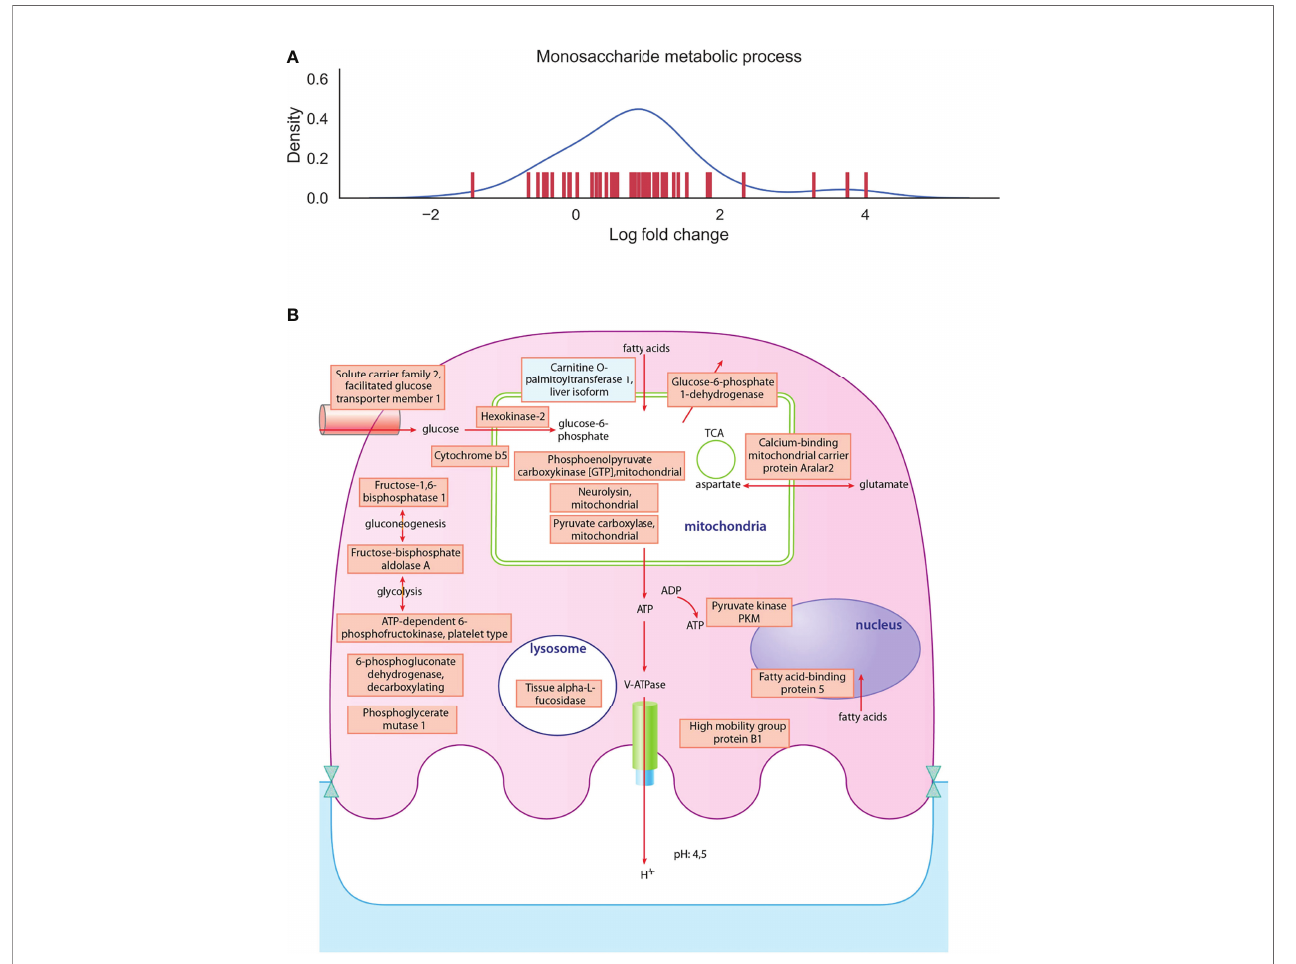
FIGURE 4 | Depiction of proteins signi fi cantly expressed in osteoclasts. (A) : The density curve and individual protein differential expression log2 values of protein expressions in the monosaccharide metabolic process pathway identi fi ed in osteoclasts. (B) : drawing represents the most signi fi cantly expressed proteins involved in monosaccharide metabolic processes in osteoclast samples compared to monocyte samples. Blue fi lling shows downregulation of proteins in osteoclast samples compared to monocytes, red fi lling shows upregulation of proteins. The full table with p values are provided in Supplementary Table 4